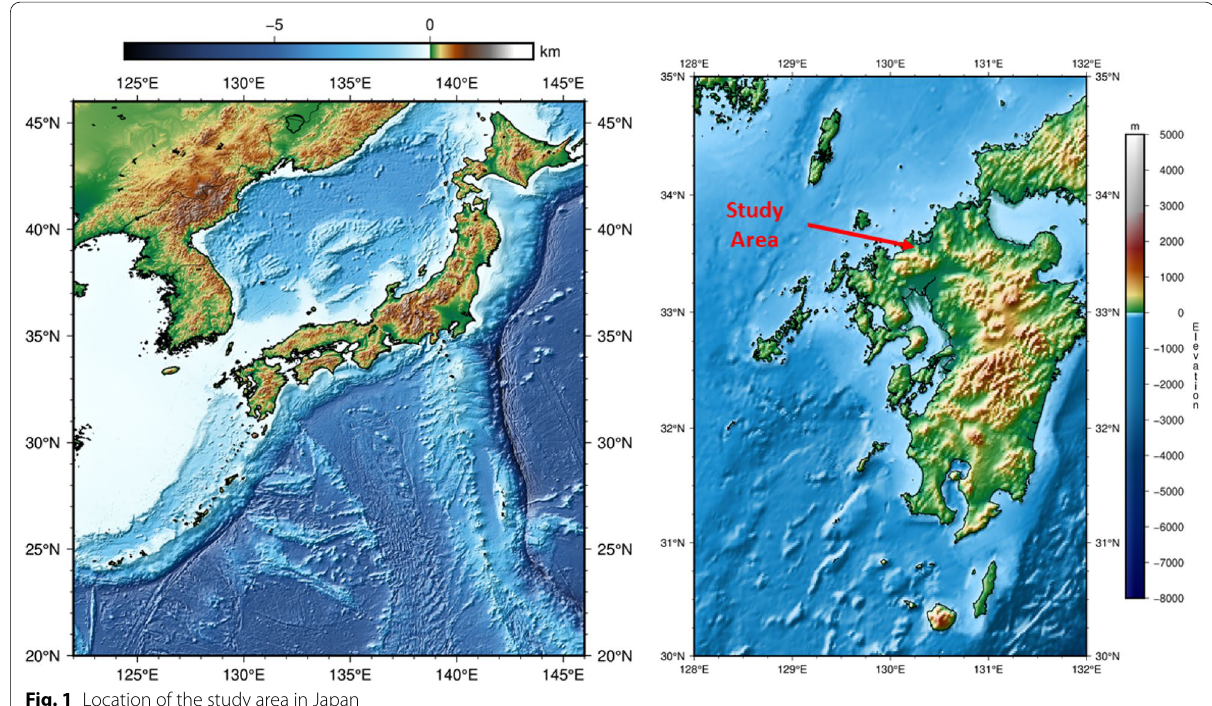
Fig. 1 Location of the study area in